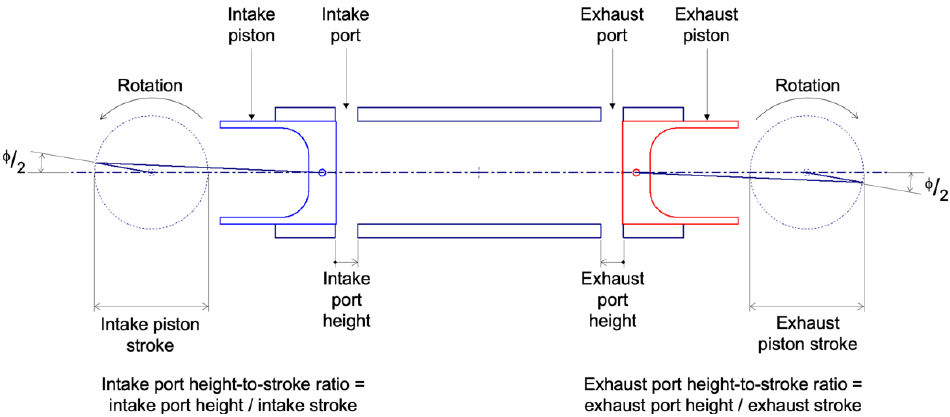
Figure 4. Scale diagram of the OP2S cylinder model drawn for a crankshaft phase angle φ of 20° at an instant when the intake and exhaust pistons lie 10° before and after bottom dead centre,